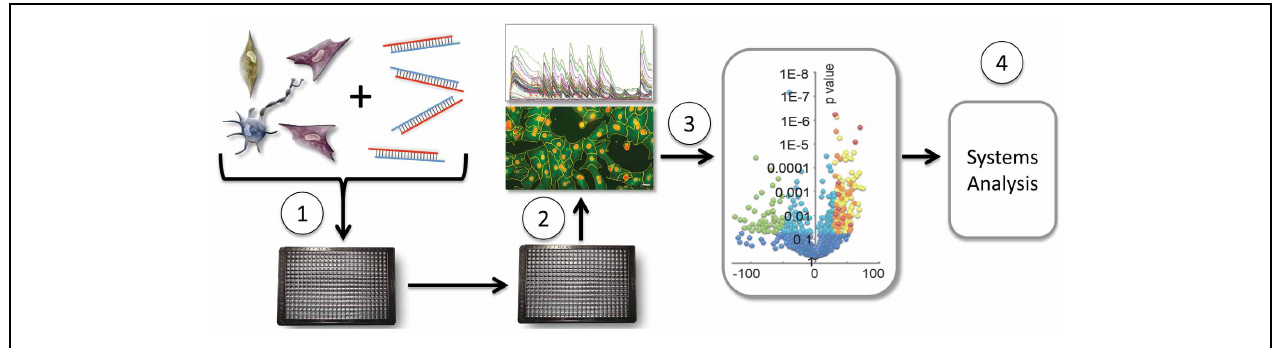
FIGURE 1 | Moderate throughputscreening of miRNAs in cell-based assays. Cells are transfected with individual miRNAs from a miRNAome library in 384-well or other multiwell format (1). Following culture, either